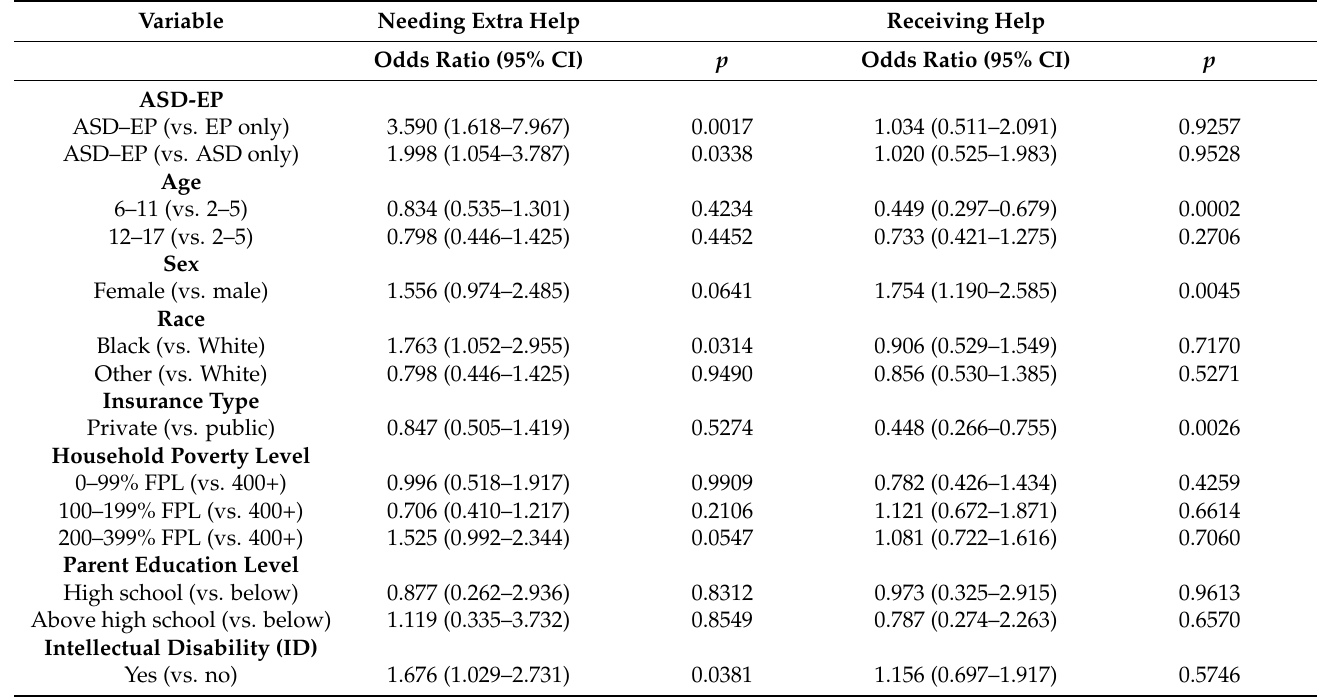
Table 4. Adjusted odds ratios for care coordination indicators.